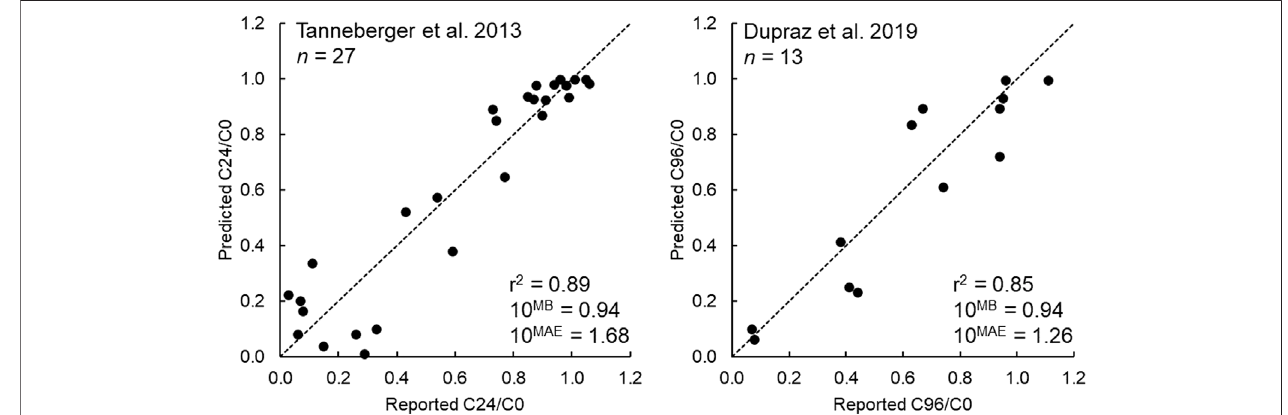
FIGURE3| Comparison ofmeasured data pointsand simulationsoftheIV-MBMDPv1.0 model foramiodarone (nmol/well)foundin celllysate and medium,given the experimental parameters described in the paper. Top left panel compares measured vs. predicted for day 0, top right panel depicts measured vs. predicted for day 13; bottom panel displays model performance of the predicted and the measured points of amiodarone mass throughout the experiment.